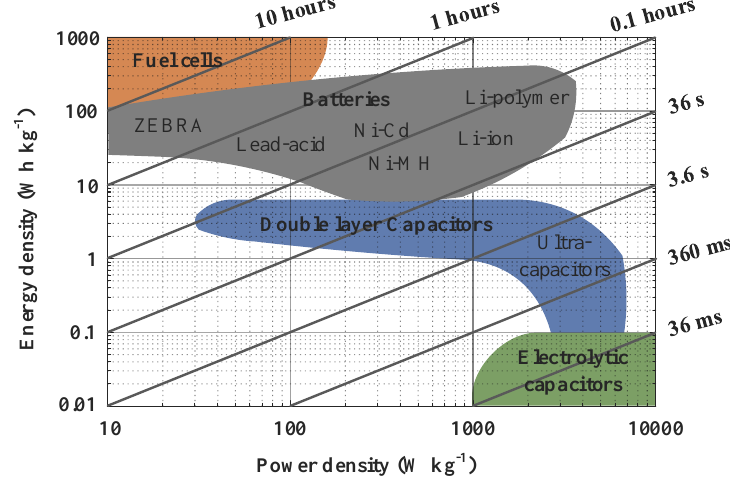
Figure 15. Energy density and power density of energy storage devices [99]. Table 5. Comparison between lithium batteries, fuel cells, and solar cells